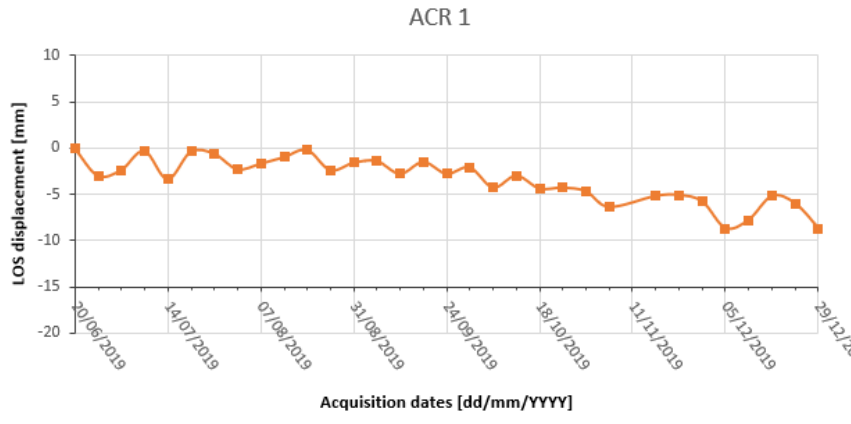
Figure 10. ACR1 displacement time series computed with respect to the reference point close to AR1